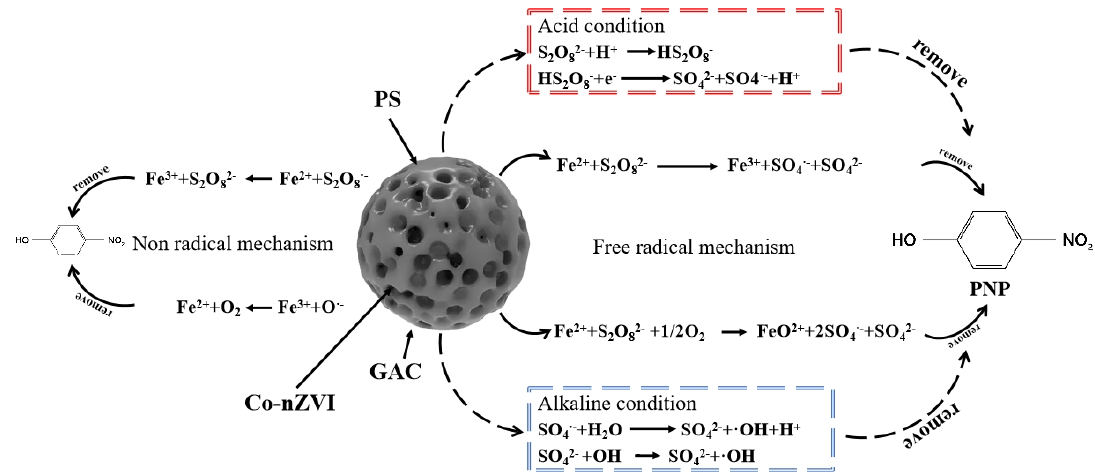
Figure 18. Mechanism analysis of PNP degradation by Co-nZVI/GAC activated PS.